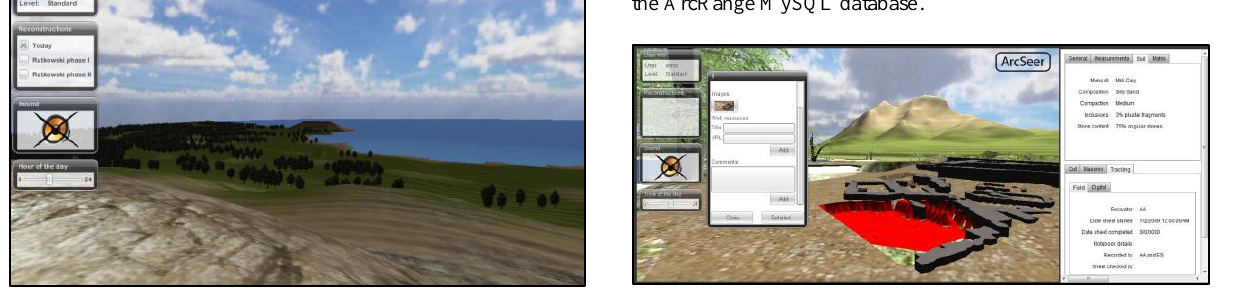
Figure 8: Surrounding landscape in the ArcSeer Petsofa project